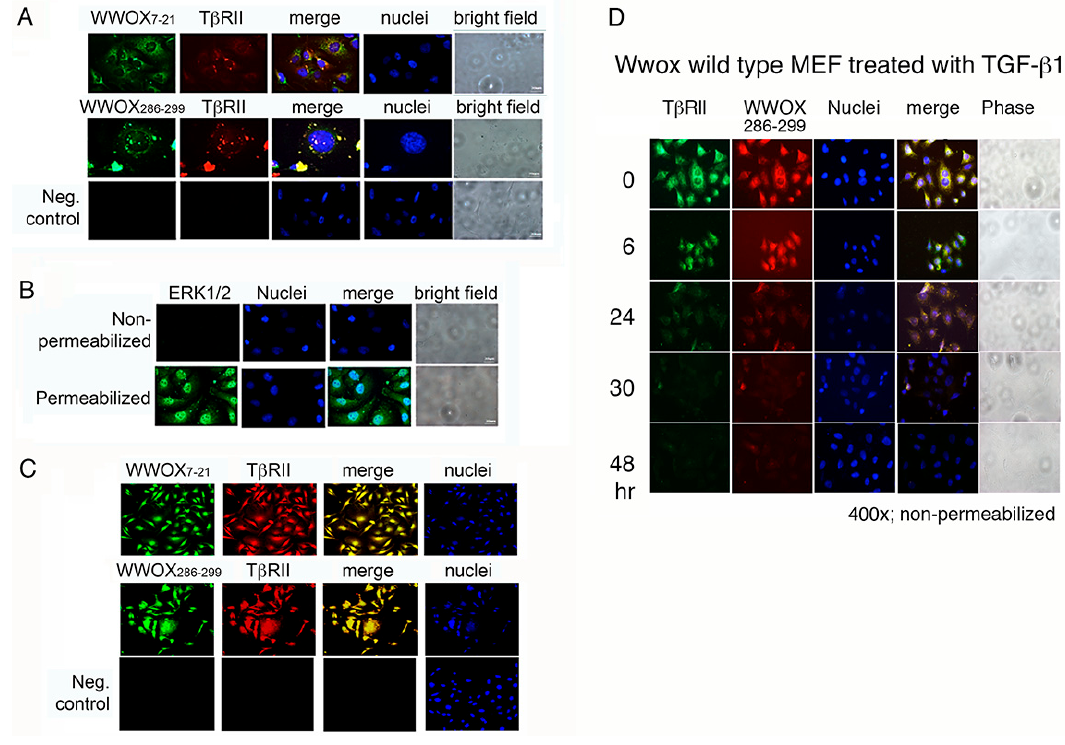
Figure 4. WWOX7-21 and WWOX286-299 peptides colocalize with cell membrane type II TGF β receptor (T β RII). ( A ) WWOX-negative MDA-MB-231 cells were incubated with WWOX7-21 or WWOX286-299 peptide at 4 °C for 30 min, followed by processing immunostaining using our